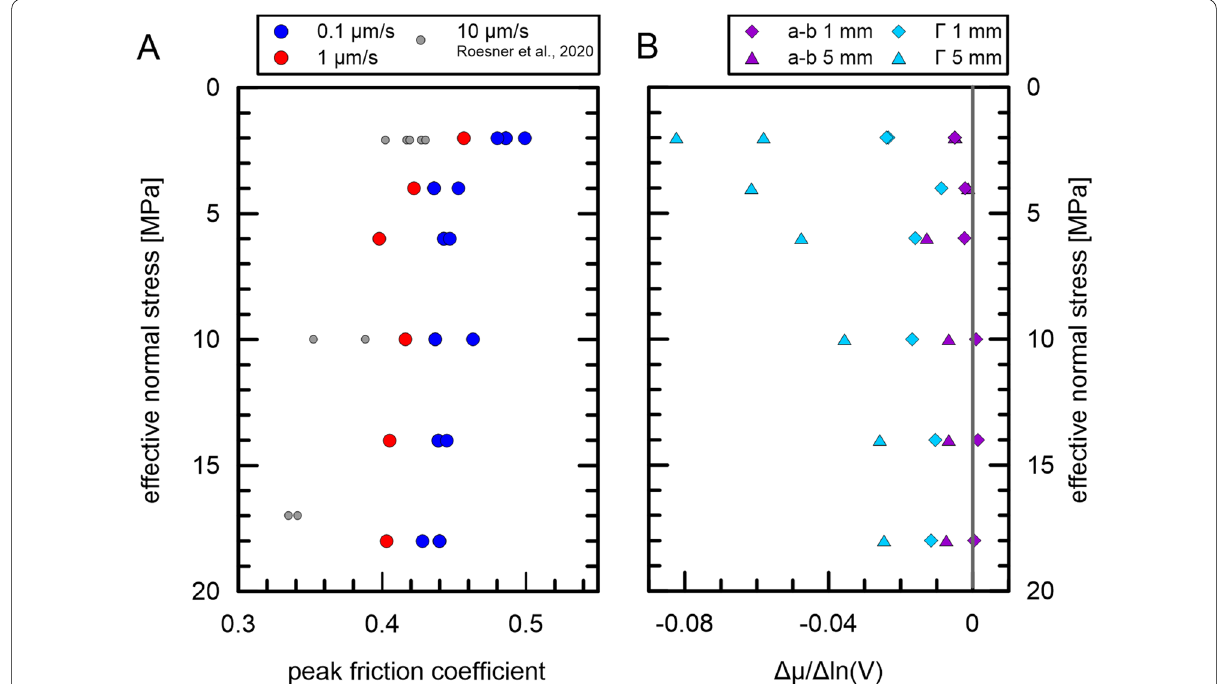
Fig. 3 Experimental results for peak friction and friction velocity dependence. A Peak friction as a function of effective normal stress. Grey circles represent C0004 megasplay fault peak friction data from Roesner et al. (2020). B Results of velocity stepping experiments showing modeled velocity dependence a-b as well as the net friction change Γ (see Eqs. 3 and